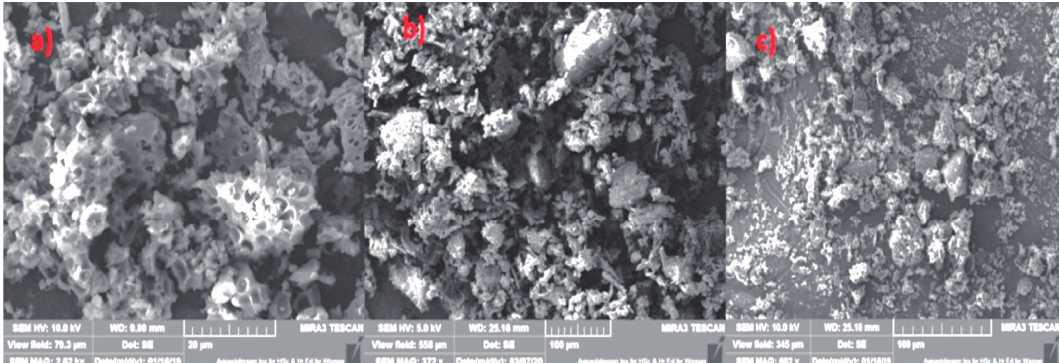
Figure 3: FESEM micrographs of APC (a) before adsorption; (b) after CR adsorption; (c) after SF